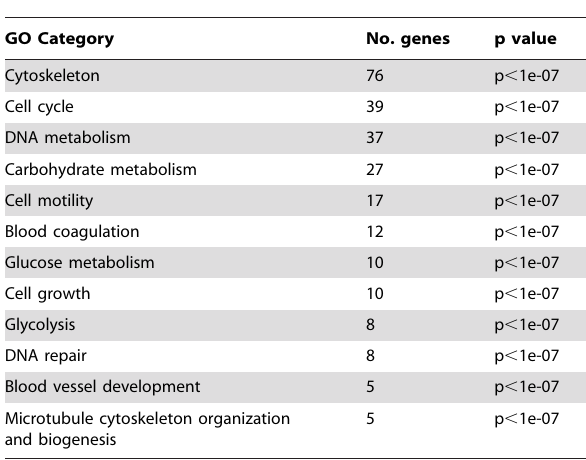
Table 1. Gene Ontology categories found to have a statistically significant higher number of genes than expected by